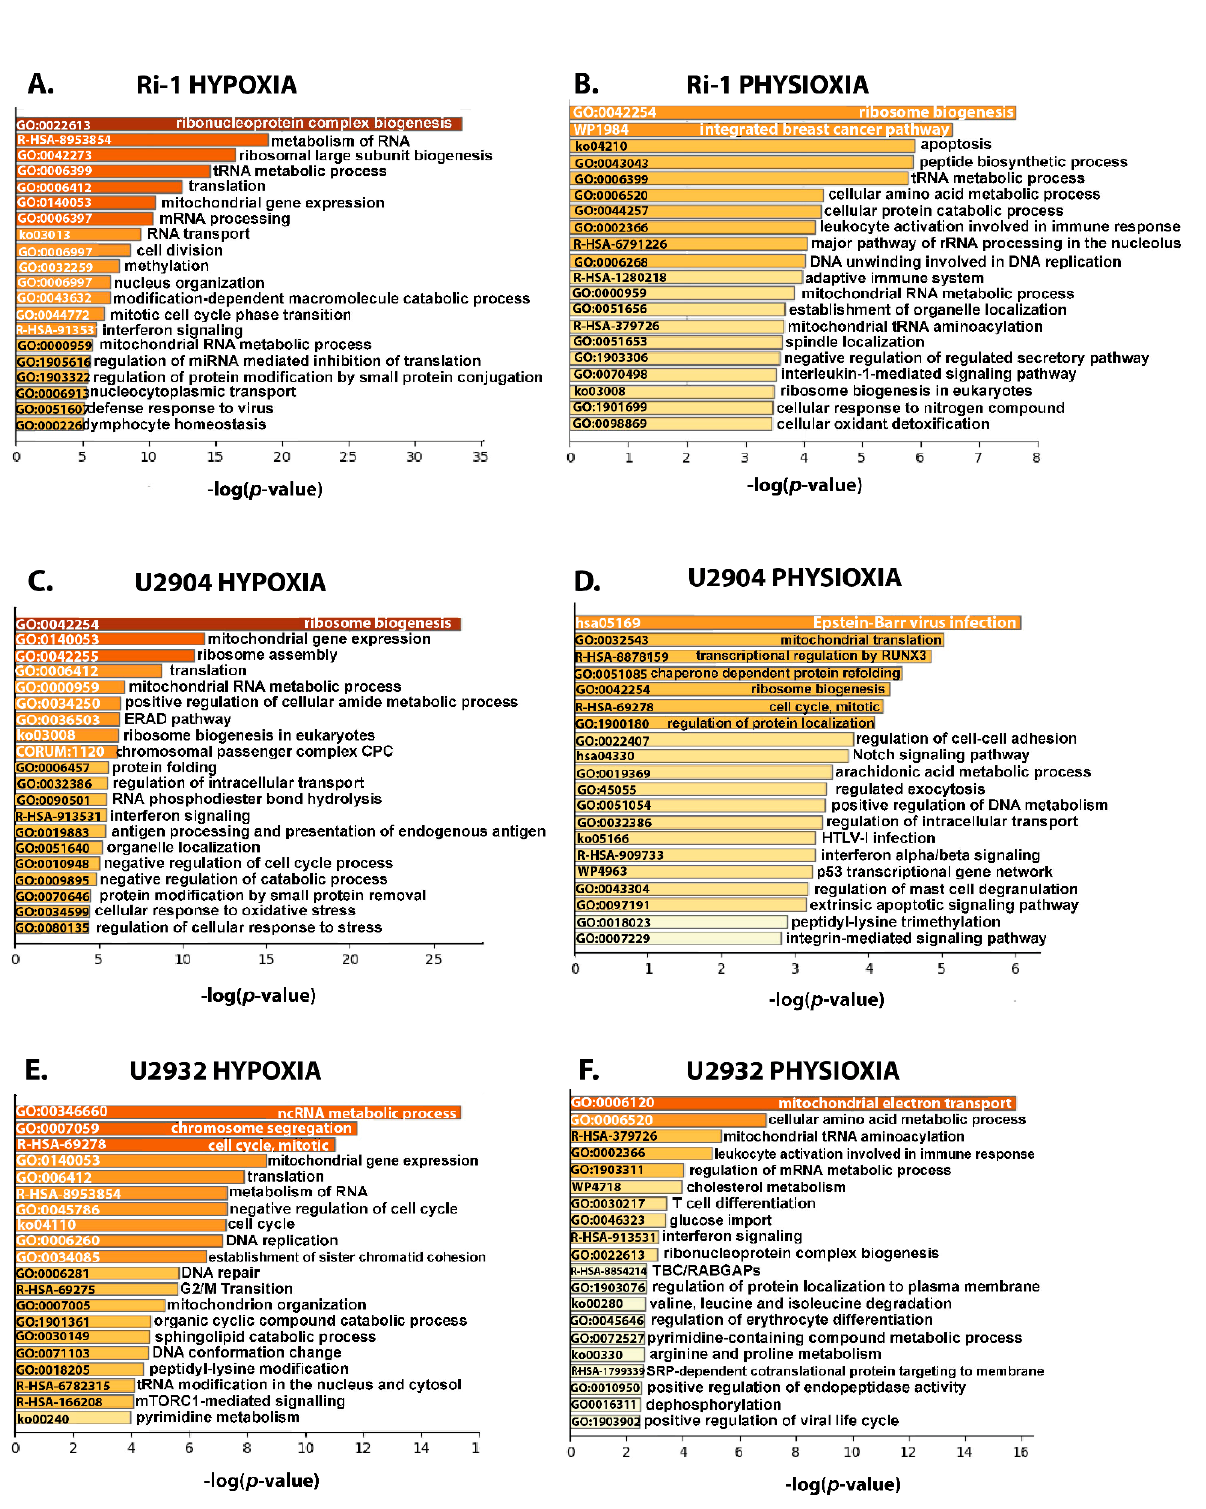
Figure 6. Enrichment analysis of downregulated proteins in hypoxia (1% of O 2 ) and physioxia (5% of O 2 ) in DLBCL cell lines using the Metascape database. The top 20 clusters with their representative enriched terms (one per cluster) are presented for each experimental condition. ( A ) The enrichment of 511 and 158 significantly downregulated proteins in hypoxia and ( B ) physioxia, respectively, in Ri-1 cell line. ( C ) The enrichment of 283 and 126 significantly downregulated proteins in hypoxia and ( D ) physioxia, respectively, in U2904 cell line. ( E ) The enrichment of 263 and 151 significantly downregulated proteins in hypoxia and ( F ) physioxia, respectively in U2932 cell line. The x-axis shows the significance, which is the value of –log10(P). Enriched terms are colored by p -values.